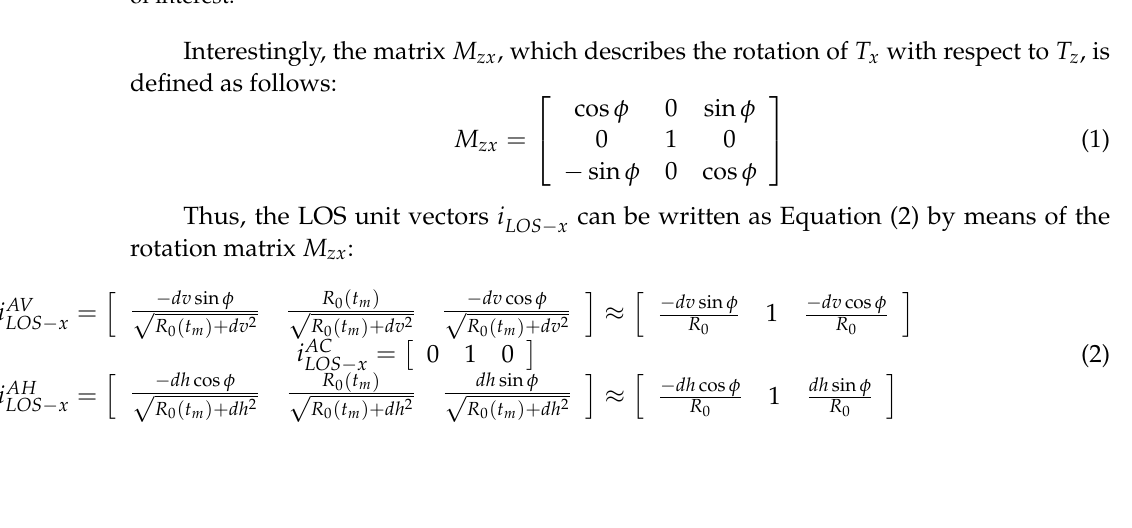
Figure 2. 3D InISAR system. ( a ) General scene for InISAR imaging. ( b ) Geometry of radar and target of interest.